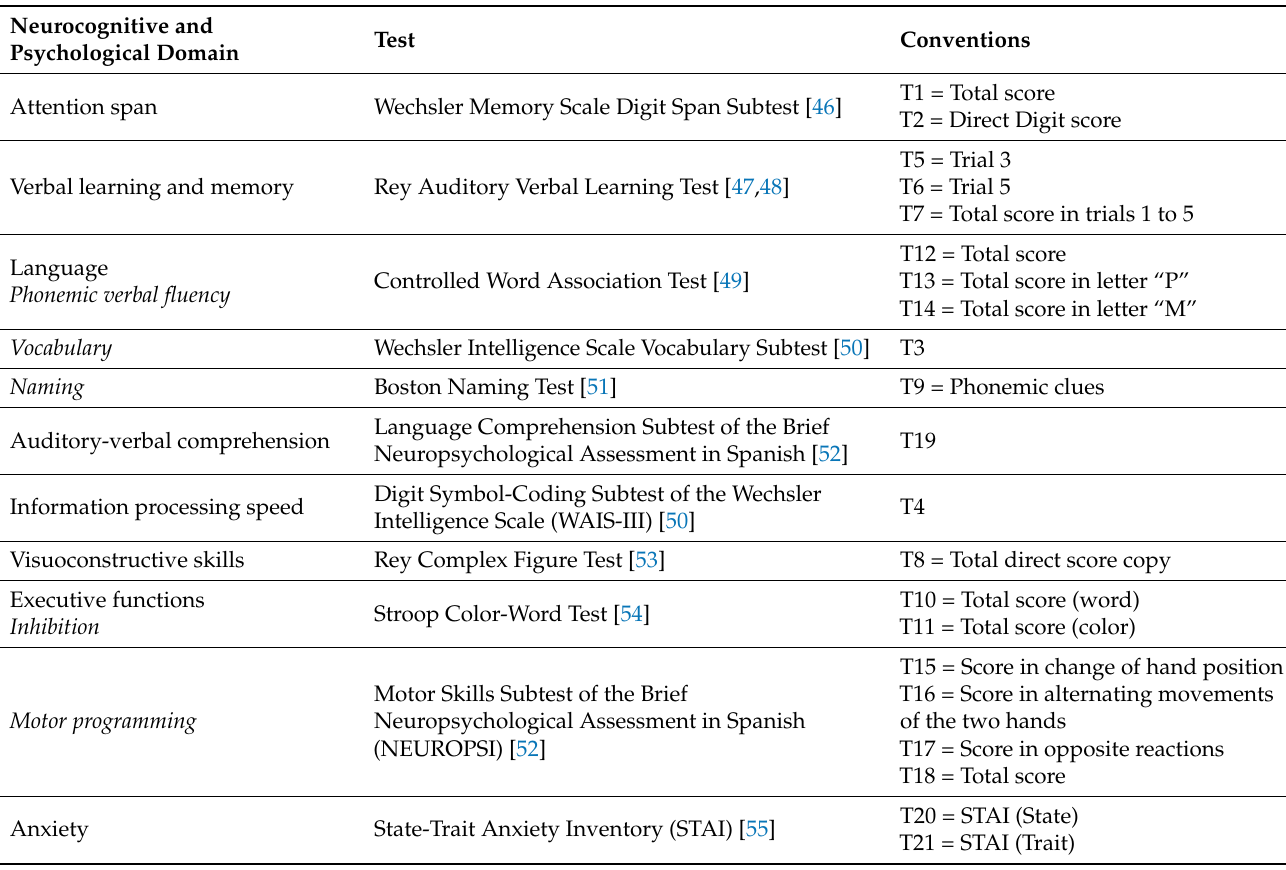
Table 2. Neurocognitive and psychological tests included in our proposed brief screening protocol for detecting HAND. Neurocognitive and Psychological